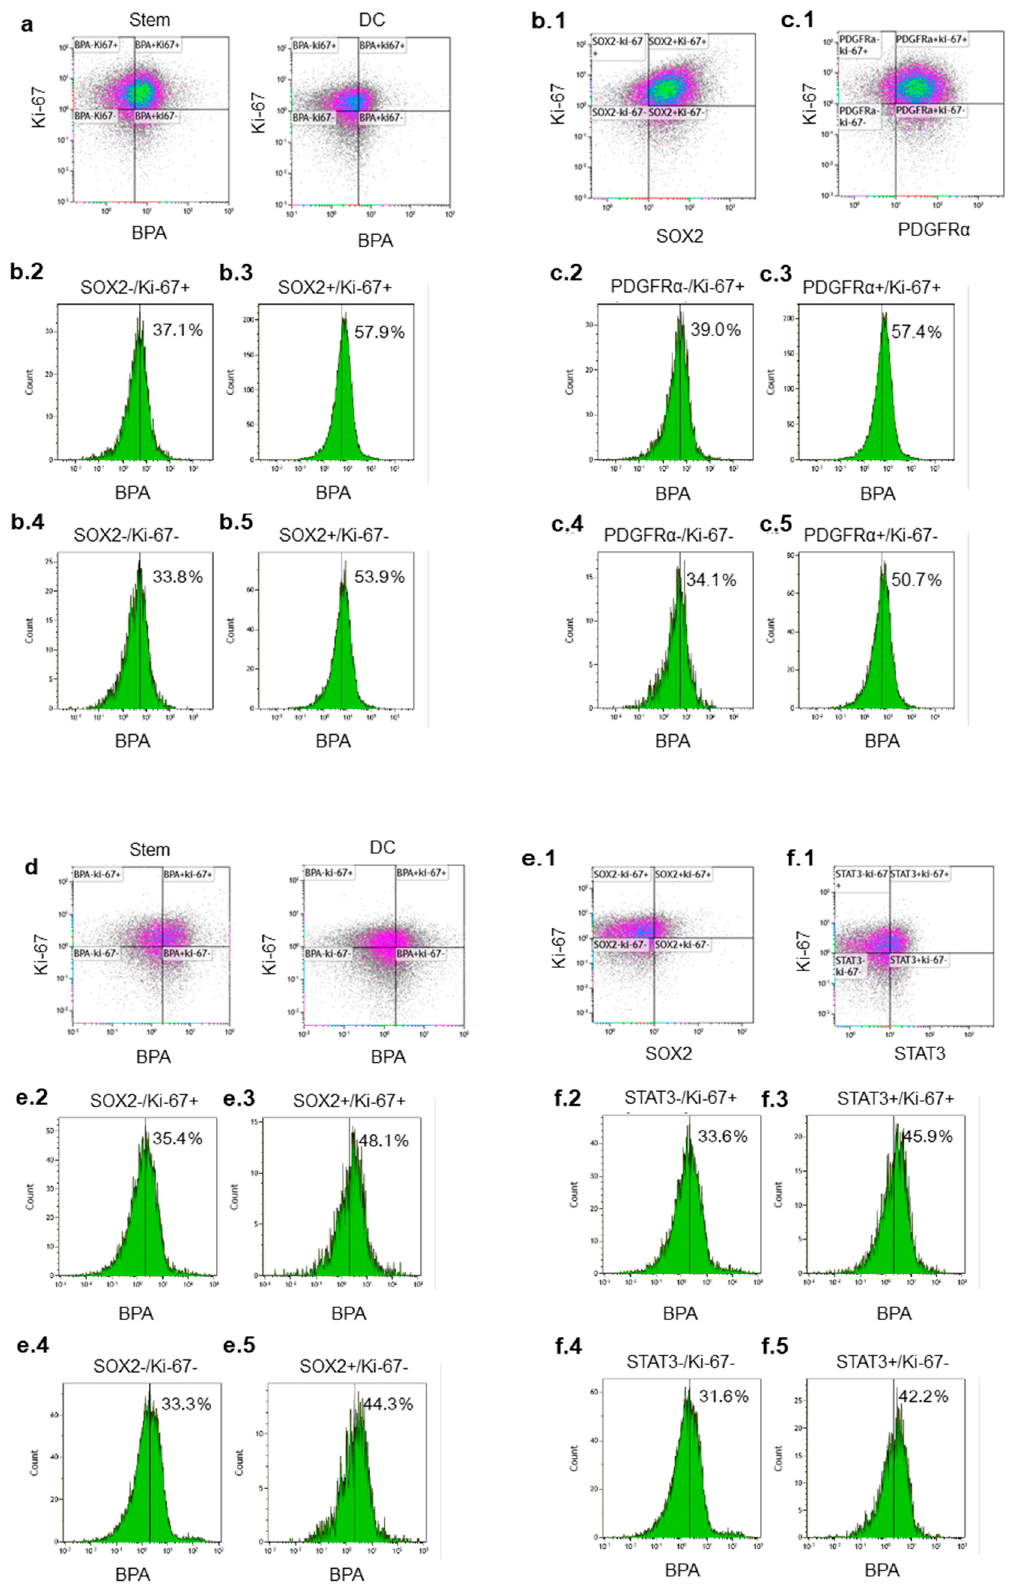
Figure 2. Relationships among proliferation marker Ki-67, stem markers and BPA uptake. ( a ) Total stem and di ff erentiated cells (DC) from no. 1 cells and expressions of ( b.1 ) SOX2 and ( c.1 ) PDGFR α in no. 1 stem-like cells; ( d ) total stem and DC from no. 2 cells and expressions of ( e.1 ) SOX2 and ( f.1 ) STAT3 in no. 2 stem-like cells. Percentages in ( b.2 – 5 ), ( c.2 – 5 ), ( e.2 – 5 ) and ( f.2 – 5 ) indicate BPA + cells for each stem marker + or stem marker − / Ki-67 + or Ki-67 −